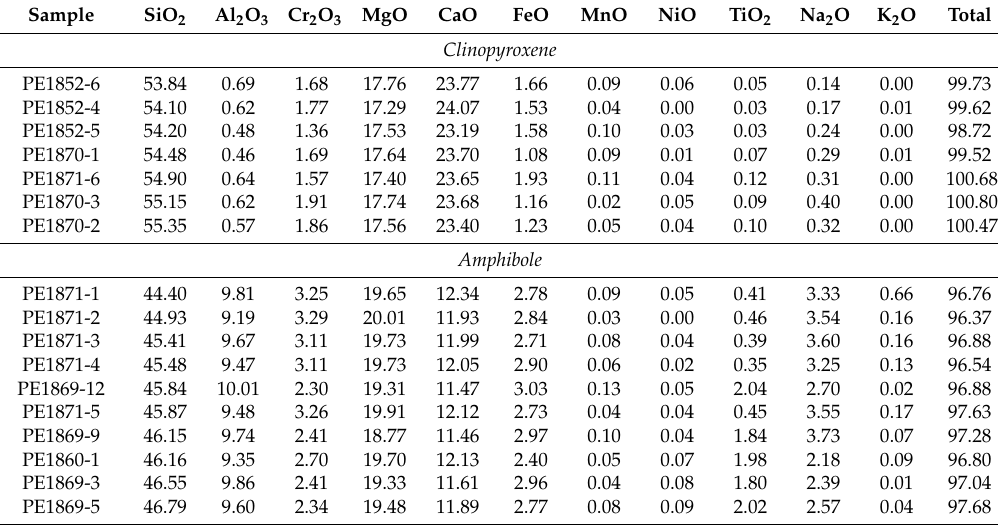
Table A3. Representative electron microprobe analyses (wt %) of clinopyroxene and amphibole included in chromite from chromitites of Alapaevsk.